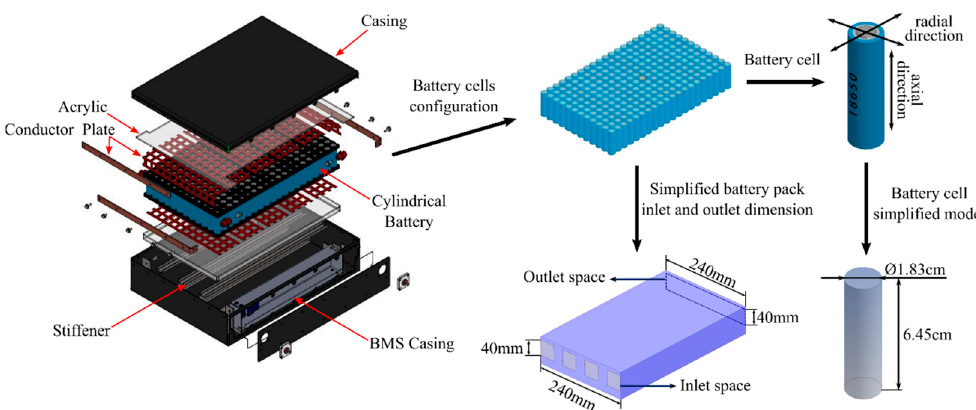
Figure 1. Battery pack design and its simplification model.